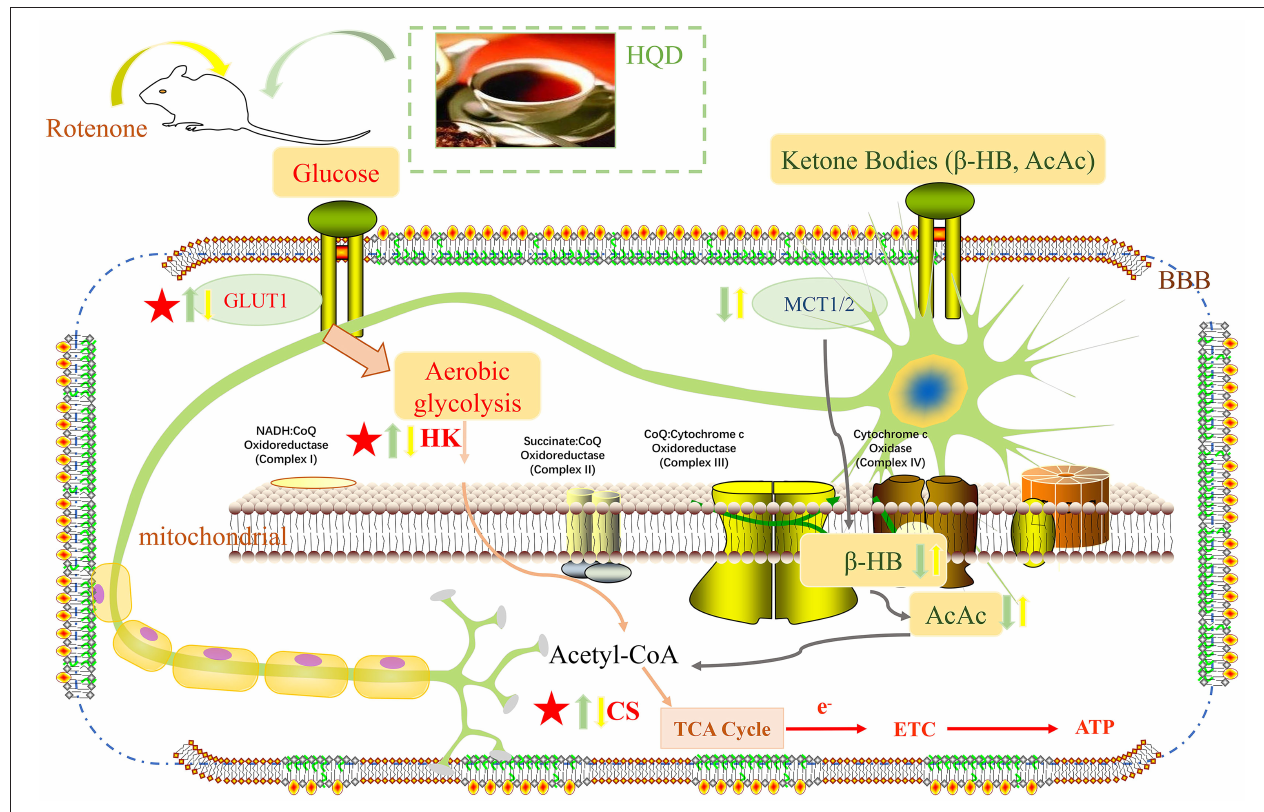
FIGURE 11 | Potential mechanism of HQD for the protective effects in rotenone-induced PD rats. Yellow arrow represents the action of rotenone, green arrow represents the action of HQD, upward arrow represents up-regulation, and downward arrow represents down-regulation.